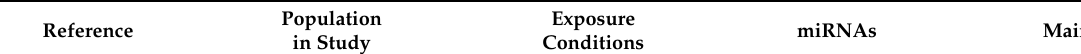
Table 3. The main outcomes from human epidemiological